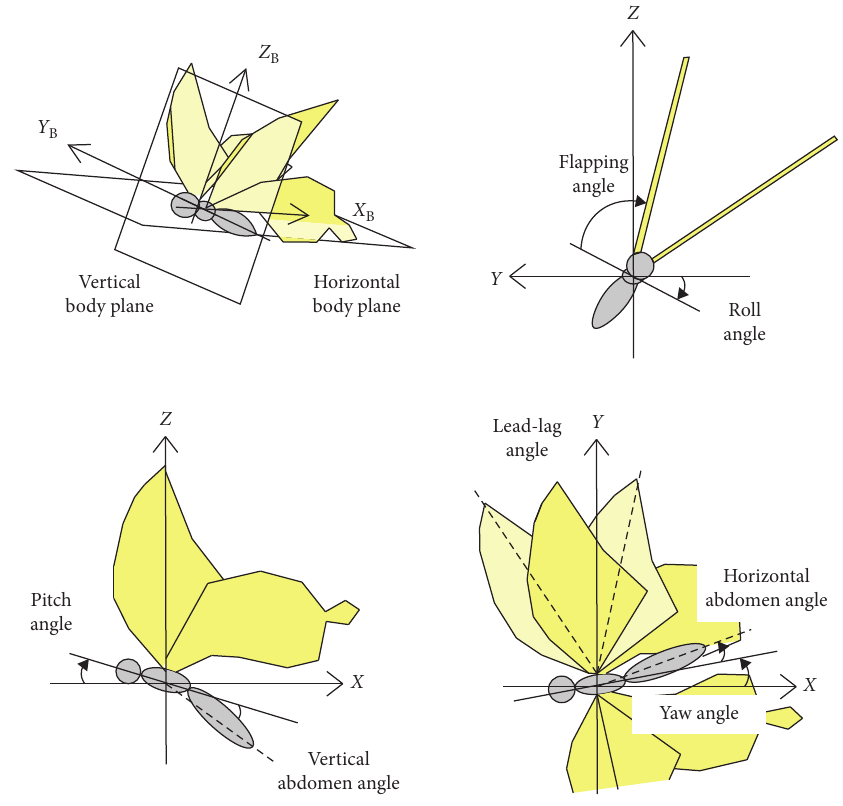
Figure 6: Definition of the butterfly frame, angles, and posture, picture from [17].